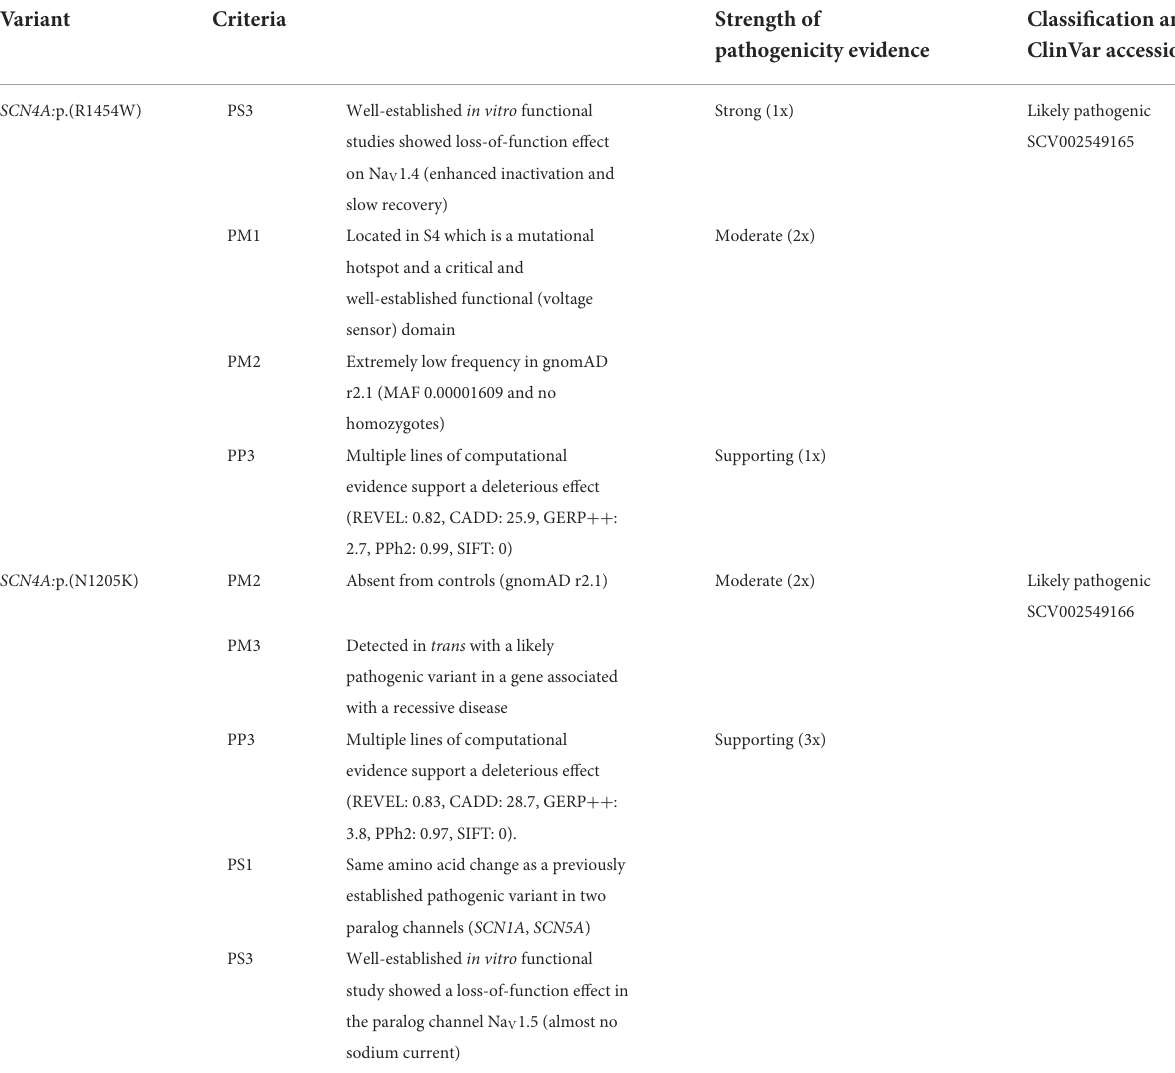
TABLE 1 Classification of two compound heterozygous SCN4A variants according to the ACMG/AMP criteria.